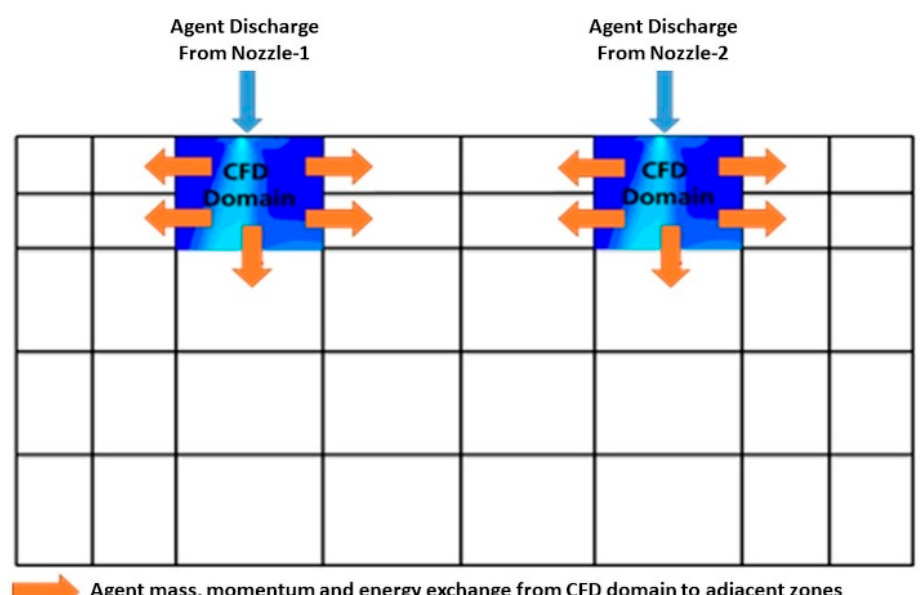
Figure 3. Schematic zonal cargo hold model coupled with two CFD domains.